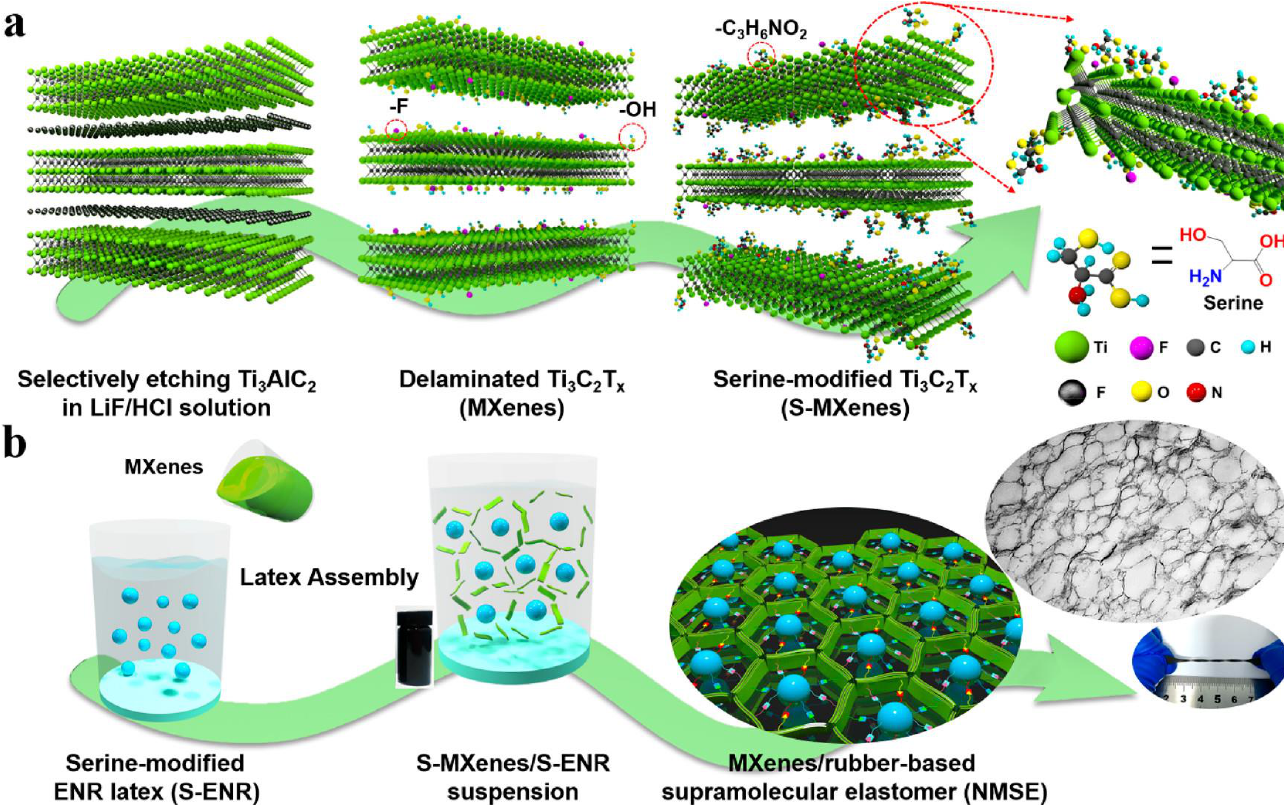
Figure 11. The main preparation process for NMSE. ( a ) Surface modification of MXene nanosheets by serine via the esterification reaction. ( b ) Construction of a nanostructured MXene network in NMSE via the latex assembly method. Adapted with permission [82]. Copyright 2020, American Chemical Society.